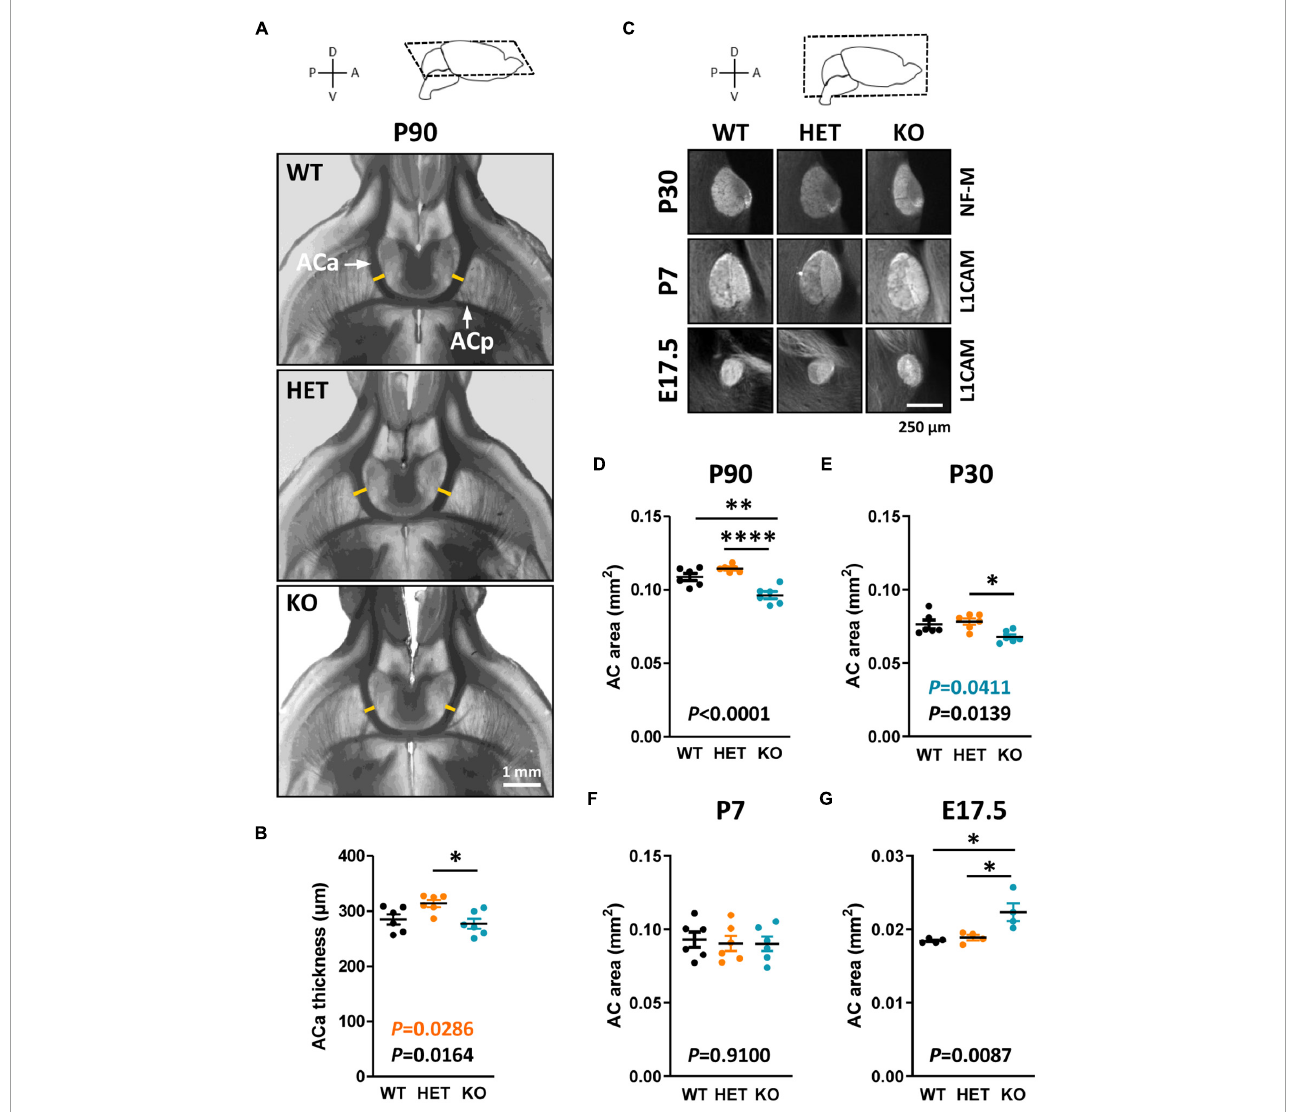
FIGURE3 Anterior commissure (AC) morphology during development and at adulthood. Representative phase-contrast images of horizontal brain sections of wild-type (WT), HET, and KO P90 mice, showing the two branches of the AC (A) ; yellow lines, levels where the thickness of the anterior branch (ACa) was measured. ACa thickness measured on horizontal brain sections of P90 mice (B) . Representative images of mid-sagittal brain sections of WT, HET, and KO mice at P30, P7, and E17.5, showing AC immunostained with anti-NF-M (P30) or L1CAM (P7, E17.5) antibodies (C) . AC area measured on mid-sagittal brain sections of P90 (D) and P30 (E) mice, P7 pups (F) , and E17.5 embryos (G) . (B,D–F) Six animals/genotype, (G) four animals/genotype, (B) average of measurements on both hemispheres on one section/animal, (D–G) average of measurements on three consecutive sections/animal. Statistical tests: Unpaired t- test (B,D,F,G) or Mann–Whitney test (E) to compare HET or KO mice to WT mice, and one-way ANOVA test (B,D,F,G) or Kruskal–Wallis test (E) to compare the three genotypes; ∗ P < 0.05, ∗∗ P < 0.01, ∗∗∗∗ P <